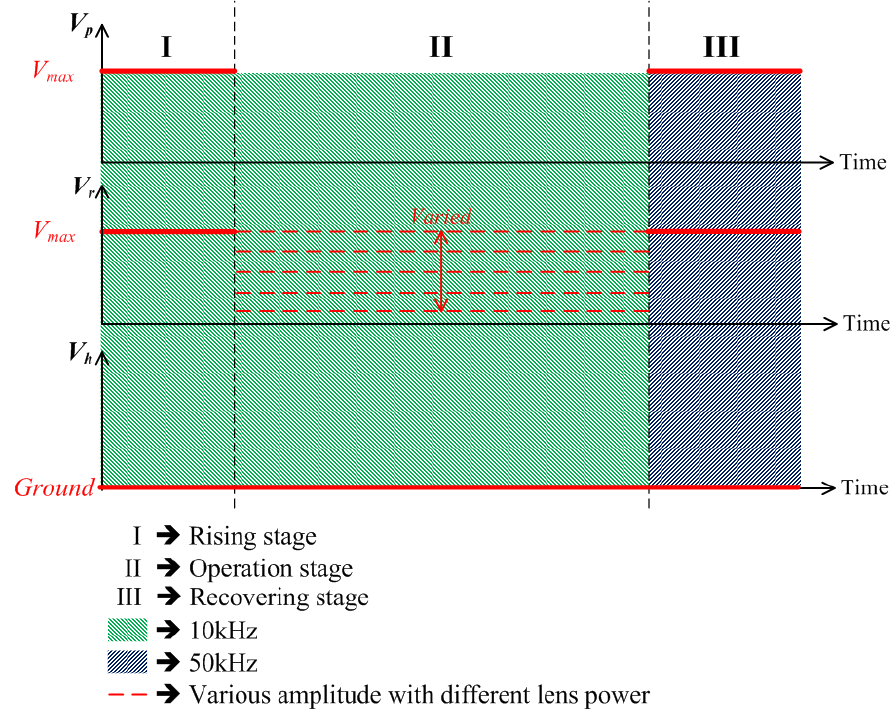
Figure 3. The driving scheme for the proposed DFLC